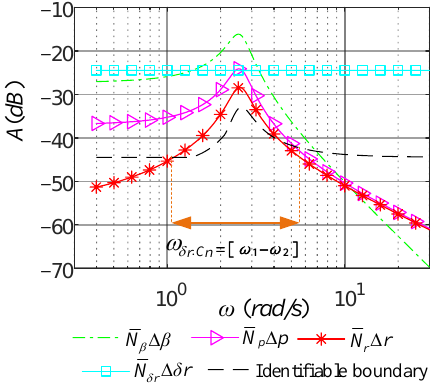
Figure 9. Amplitude–frequency characteristic curve of the yawing moment component with the change in rudder frequency.